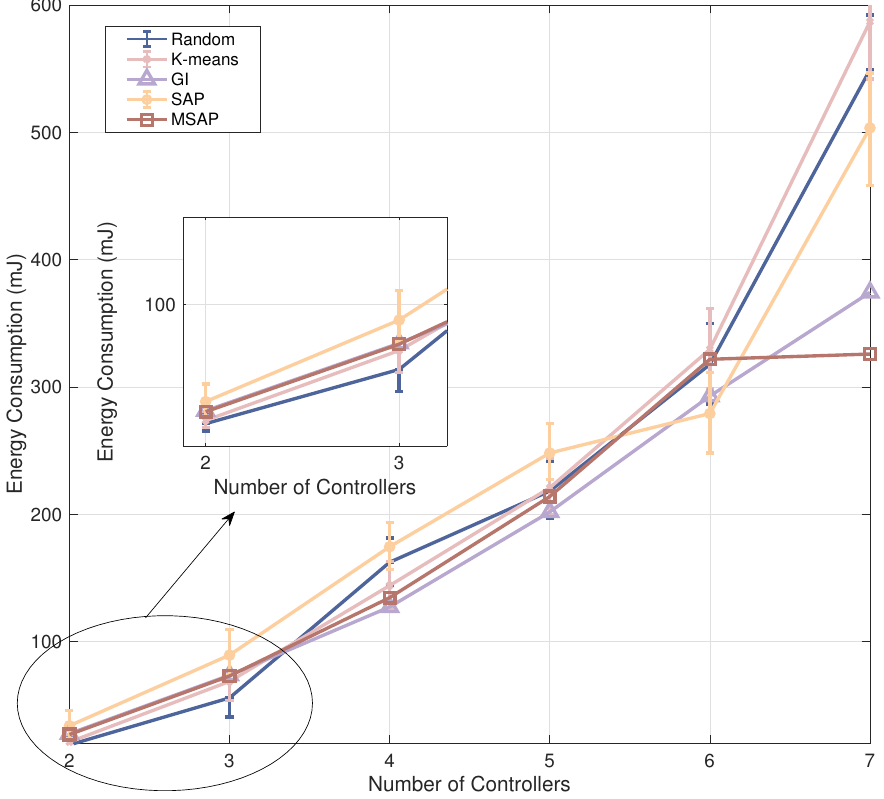
Figure 7. Energy consumption for controllers in the LEO satellite